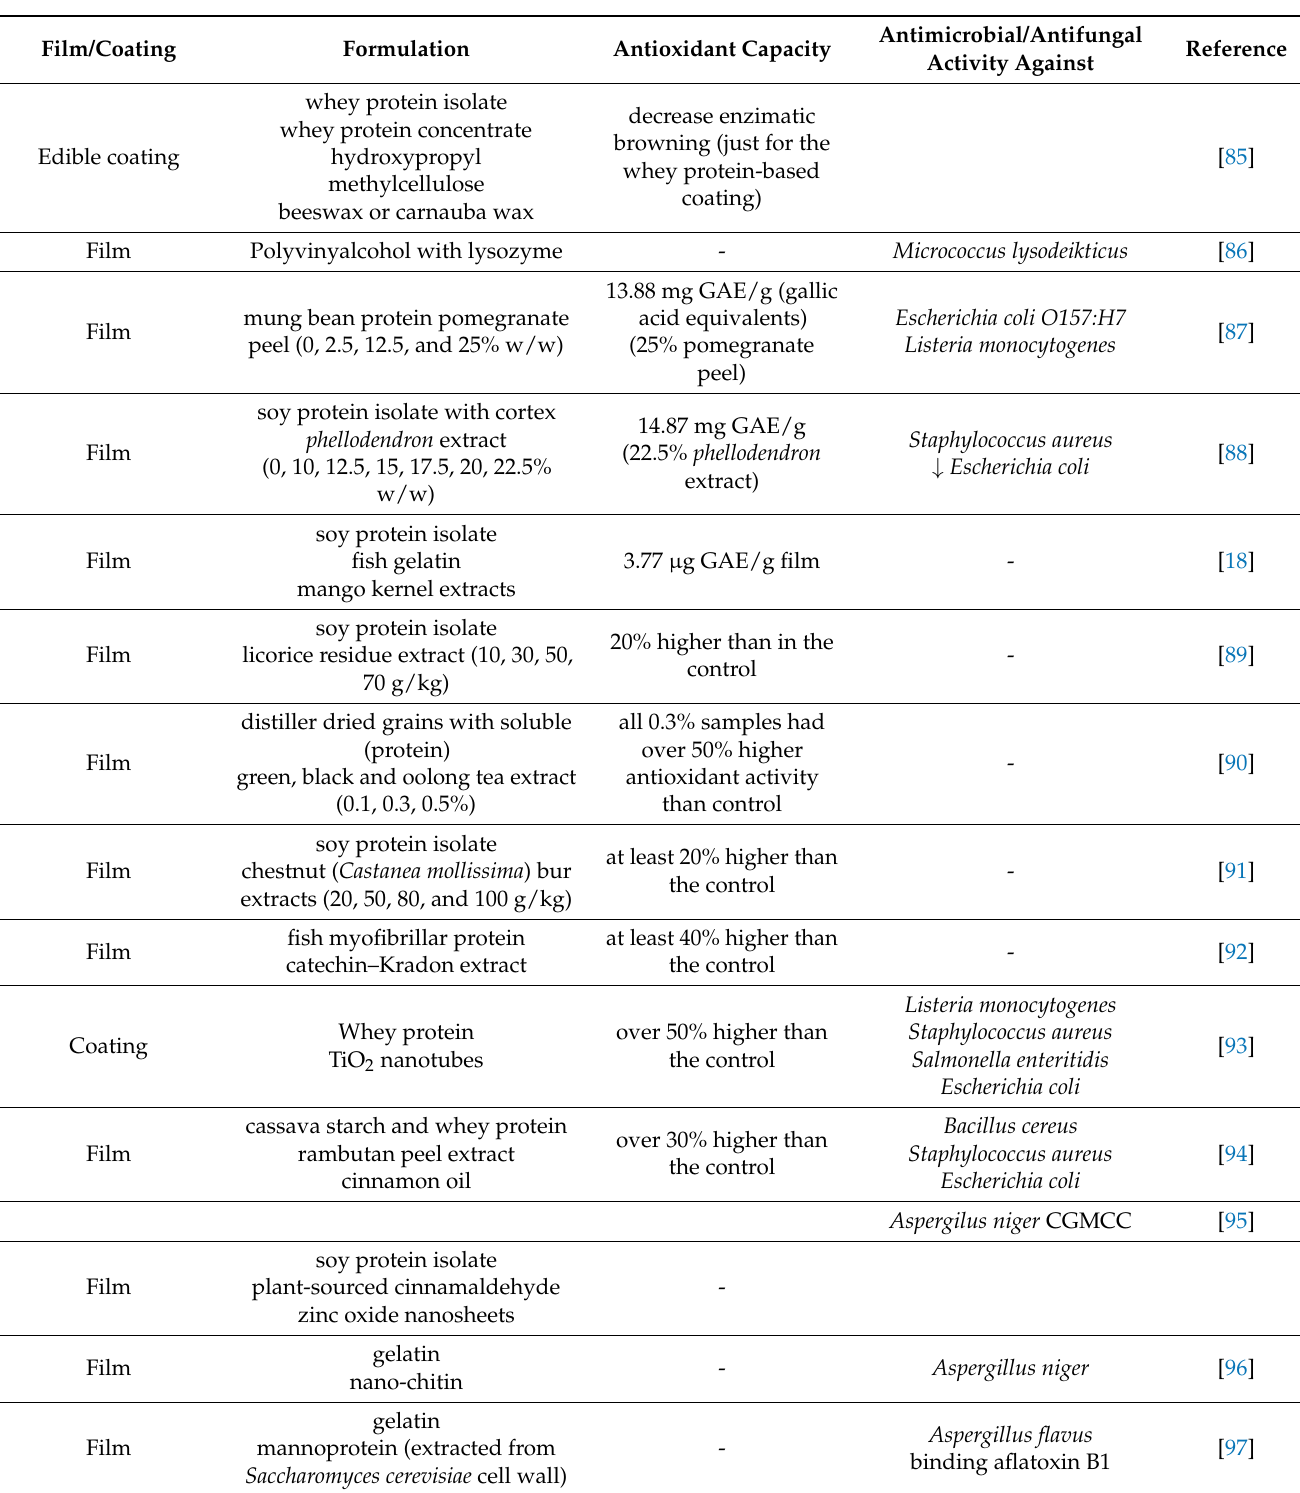
Table 3. Antioxidant, antimicrobial and antifungal activity of protein-based films and